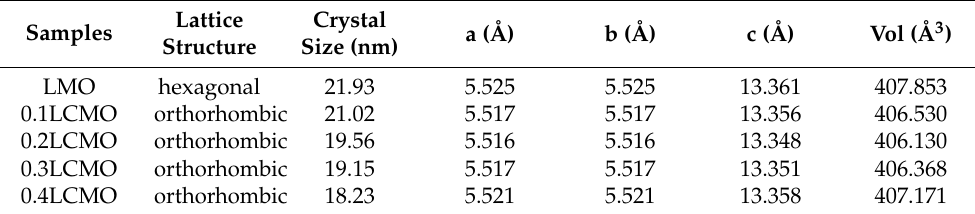
Figure 1. XRD patterns of as-prepared redox catalysts. Table 1. Lattice structure, crystal size and lattice parameters of each fresh sample.